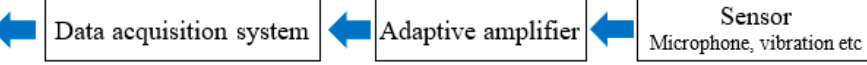
Figure 3. Schematic diagram of noise and vibration acquisition.